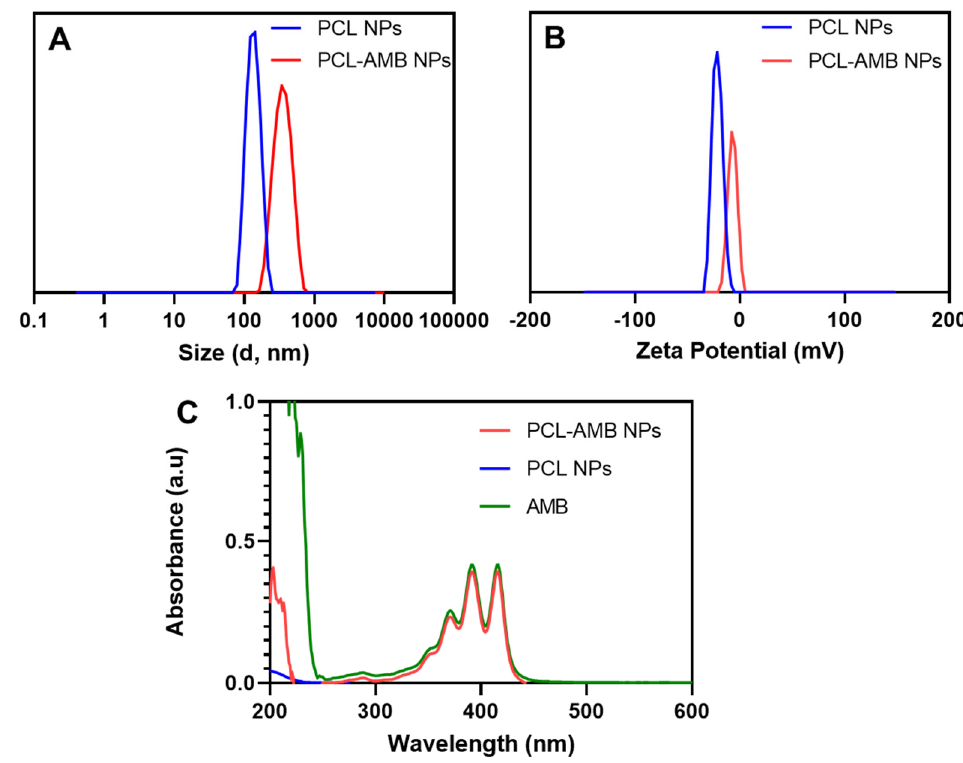
Figure 1. SEM image of PCL NPs ( A ) and PCL-AMB NPs ( B ). Size distribution of PCL NPs ( C ) and